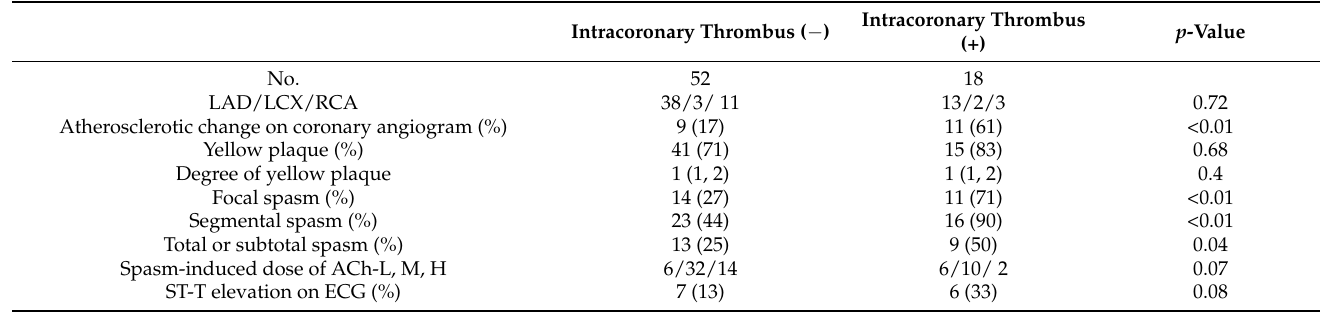
ACh, acetylcholine; ECG, electrogram; LAD, left anterior descending coronary artery; LCX, left circumflex coronary artery; No., number; RCA, right coronary artery. Low, moderate and high doses of ACh (L-ACh, M-ACh, H-ACh), were defined as 20, 50 and 80 µ g for the RCA and 50, 100 and 200 µ g for the LCA,